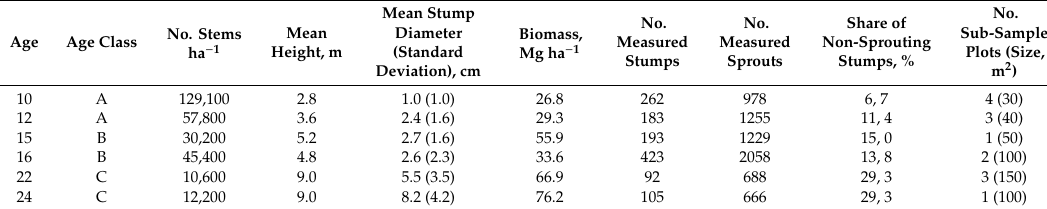
Table 1. Stand age, stand density, mean height and leafless above-ground biomass of the stands before clearcutting, and the number of measured stumps, their mean diameter, number of measured downy birch sprouts, and share of non-sprouting birch stumps after the first growing season after clearcutting and number of sub-sample plots.